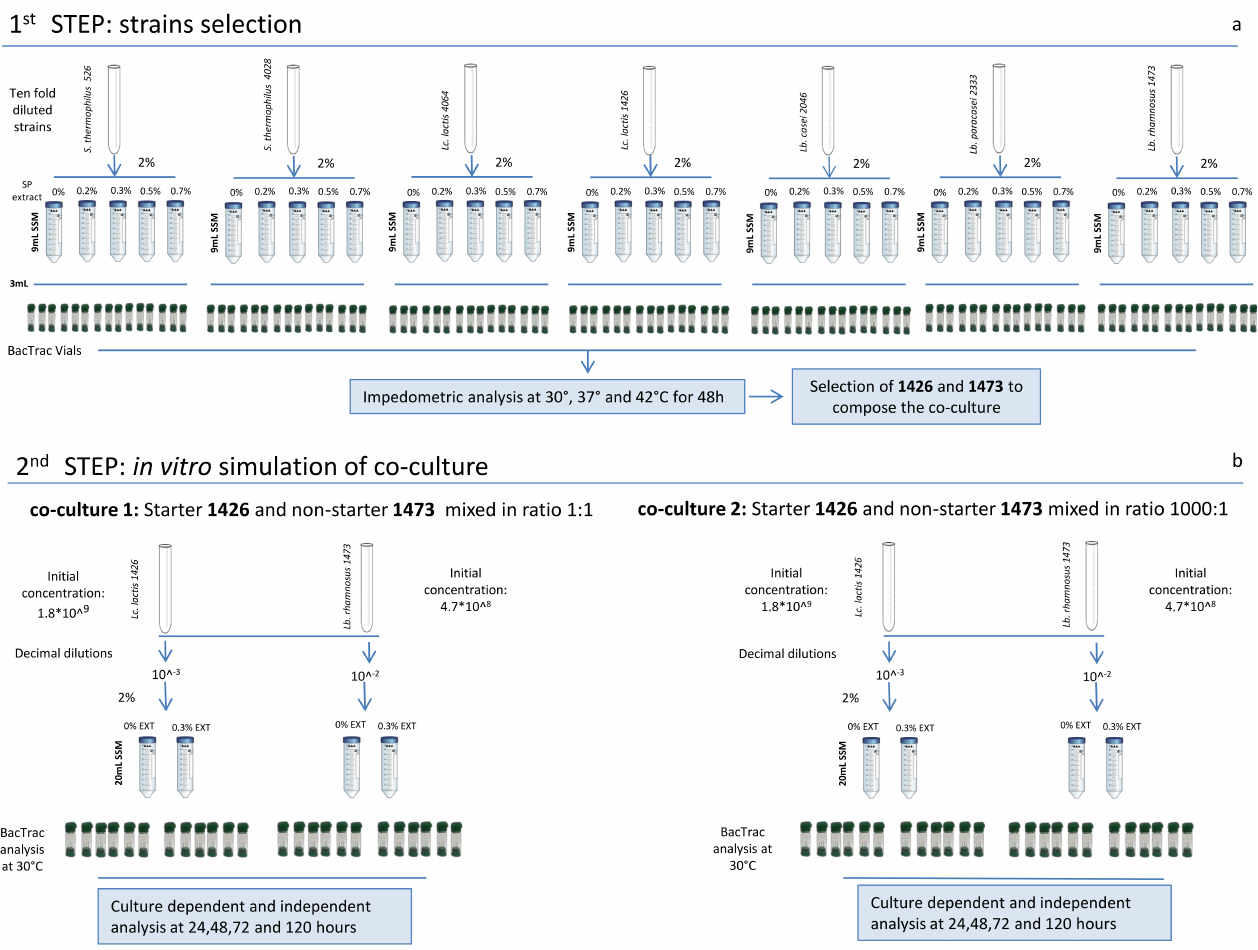
Figure 1. Experimental design. In the figure ( a ) the scheme of the strain selection precudure is reported, and ( b ) the schematic representation of the in vitro simulation of co-culture is reported.